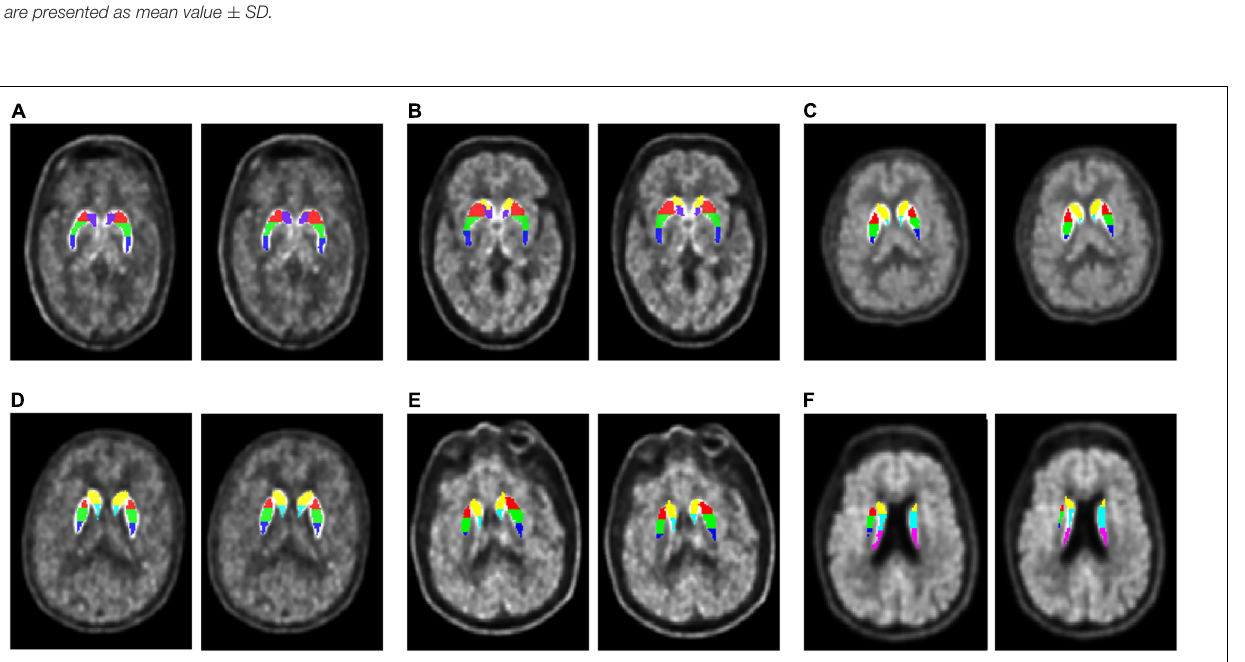
FIGURE 3 | Segmentation results comparison. Each subgraph consists of a subject’s original PET image, superimposed with seven subregion labels obtained by two segmentation methods, the multi-atlas-based method (left) and the MR-based method (right). Both PDs and HCs from cohort UI and GE were selected to demonstrate their segmentation effects at different cross-sectional slices. (A) A 46-year-old HC (male) in cohort UI case 4. (B) A 56-year-old PD (female) in cohort UI case 20. (C) A 48-year-old PD (female) in cohort GE case 3. (D) A 59-year-old HC (female) in cohort UI case 12. (E) A 61-year-old PD (male) in cohort UI case 32. (F) A 75-year-old PD (male) in cohort GE case